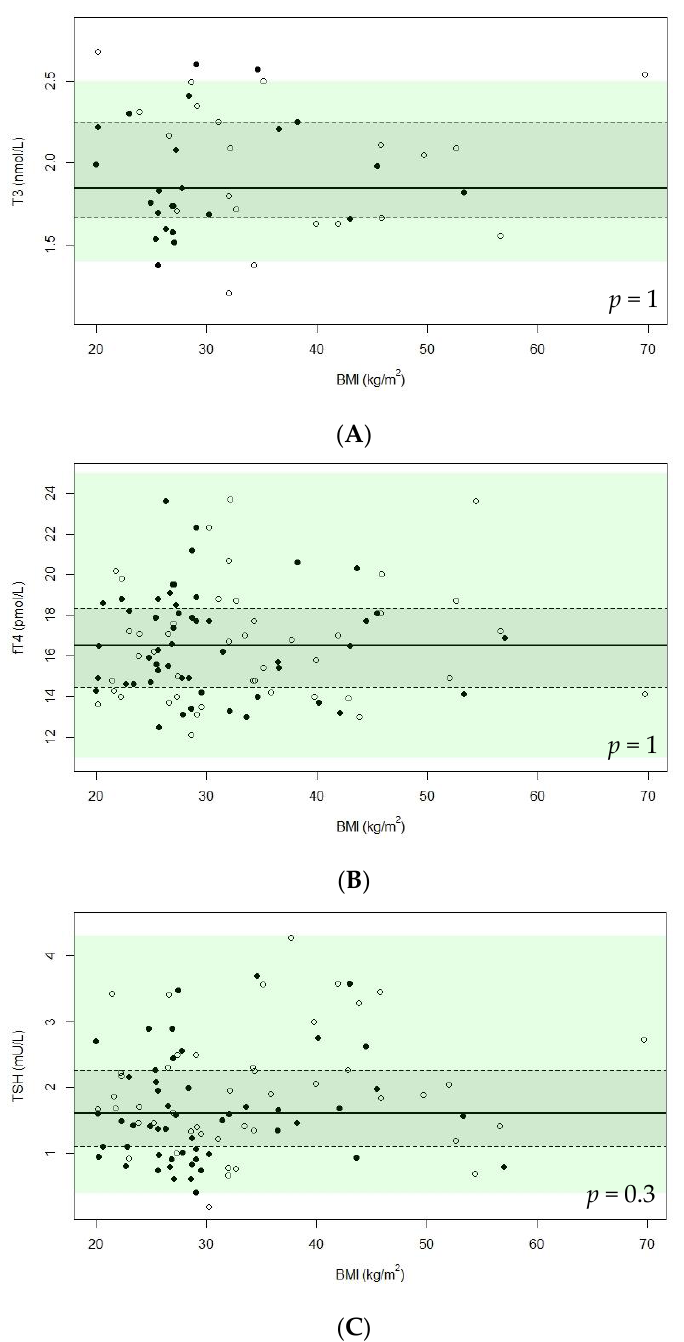
Figure 1. Scatterplots of T3, fT4, and TSH in relation to BMI. Abbreviations: body mass index (BMI), free thyroxine (fT4), triiodothyronine (T3), thyroid-stimulating hormone (TSH). Only patients without hyperthyroidism, hypothyroidism, or subclinical hypothyroidism are depicted in this figure. Legends: males are depicted by closed dots and females by open dots. The solid line represents the median, while the dashed line with the grey rectangle represents the interquartile range. The reference range is given as a green, transparent rectangle. ( A ) T3 vs. BMI for males and females; ( B ) fT4 vs. BMI for males and females; ( C ) TSH vs. BMI for males and females. Reference values: TSH: before 1 February 2019: 0.4 – 4.3 mU/L ( n = 69), after 1 February 2019: 0.56 – 4.27 mU/L ( n = 28); fT4: before 12 April 2019: 11 – 25 pmol/L ( n = 73), after 12 April 2019: 13.5 – 24.3 pmol/L ( n = 22); T3: before 12 April 2019: 1.4 – 2.5 ( n = 33), after 12 April 2019: 0.7 – 2.0 nmol/L ( n = 12). Only the reference range that was valid for the most observations is shown.